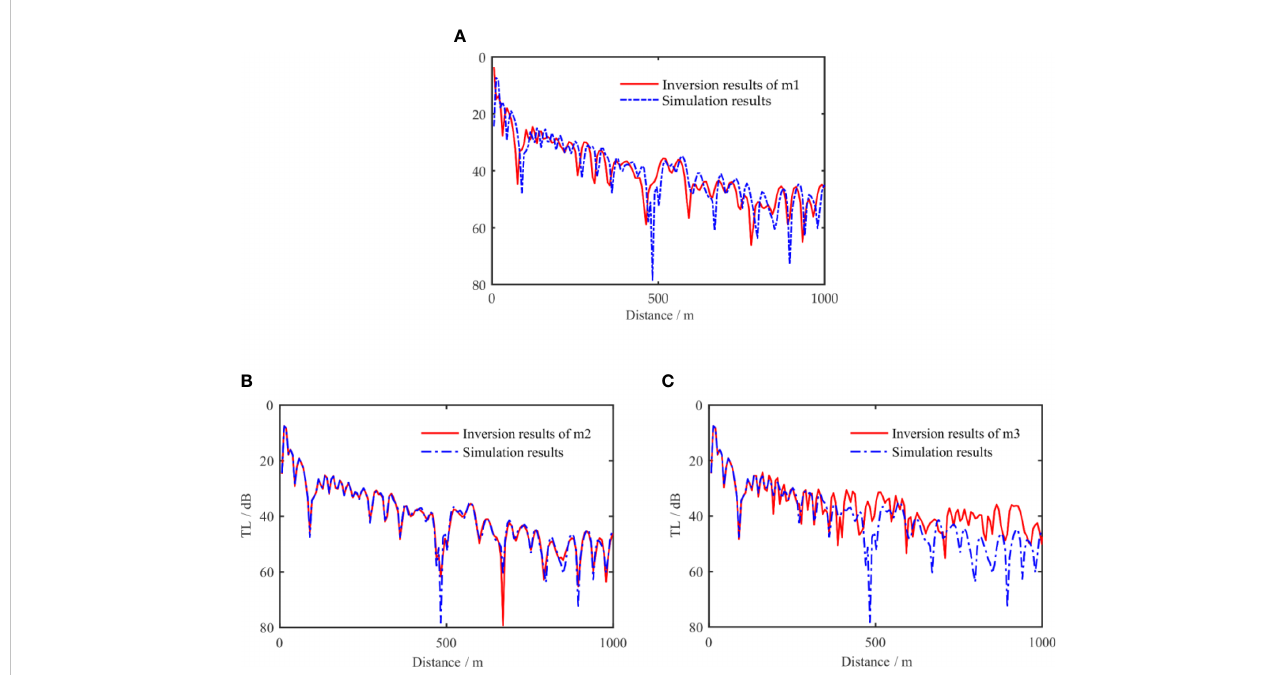
TABLE 2 Comparison of the mean and standard deviation of inversion parameters before and after improvement of the simulated algorithm. Layered Parameters True value Prior range